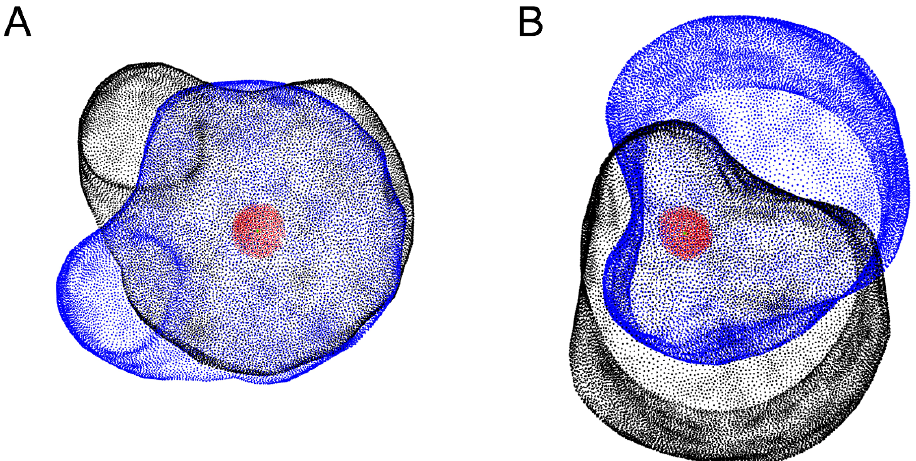
Figure 6. Typical examples of smaller TUH and forearm rotation ( A ) and greater TUH and forearm rotation ( B ). The red area shows the points with D FR values in the lowest 10%. ( A ) When the TUH or forearm rotation was smaller, the RC was located closer to the center of the ulnar head. ( B ) When the TUH or forearm rotation was greater, the RC was located closer to the center of the ulnar styloid process. Note that the fovea ulnaris is not isometric in this case.